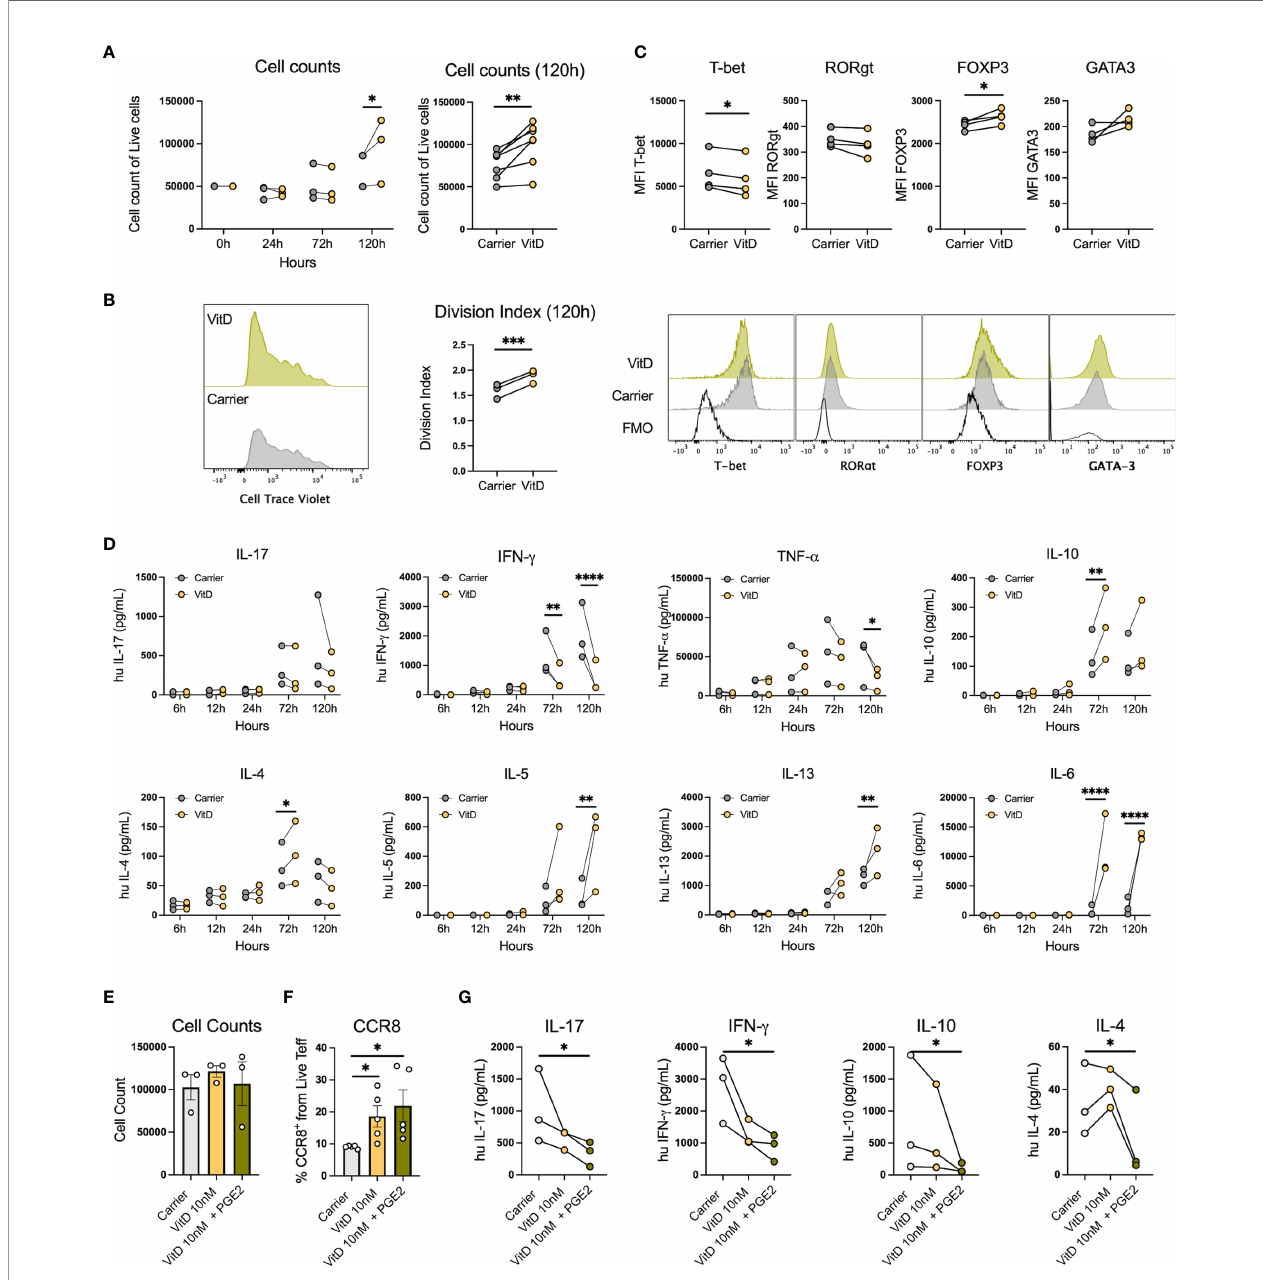
FIGURE 7 | PGE2 with VitD induce CCR8 expression and inhibit cytokine production in Th cells. (A) Representative histograms and cumulative data of cell counts and (B) division index of sorted memory Teffs (2×10 5 ) activated with anti-CD3/CD28 beads (1:5) in the presence or absence of 1,25(OH)VitD3 (10nM in ethanol) or Carrier (ethanol) at 24h, 72h and 120h post activation. Data are presented as individual symbols with paired lines (Two-way Repeated Measure ANOVA and Paired t test). (C) Representative histograms and cumulative data of transcription factor expression of sorted memory Teffs (2×10 5 ) activated with anti-CD3/CD28 beads (1:5) in the presence or absence of VitD (10nM in ethanol) or Carrier (ethanol) at 120h post activation. Data are presented as individual symbols with paired lines (Paired t test). (D) Cytokines were measured in supernatants obtained from sorted memory Teffs (2×10 5 ) activated with anti-CD3/CD28 beads (1:5) in the presence or absence of 1,25(OH)VitD3 (10nM in ethanol) or Carrier (ethanol) at 6h, 12h, 24h, 72h and 120h post activation. Data are presented as individual symbols with paired lines (Two-way Repeated Measure ANOVA). (E) Cell counts, (F) CCR8 expression and (G) cytokine production were measured in anti-CD3/CD28 pre-activated Teff cells (1x10 5 ) cocultured with carrier (ethanol), 1,25(OH)VitD3 (10nM in ethanol) or 1,25(OH)VitD3 (10nM in ethanol) in combination with PGE2 (5uM) for 72h with fl ow cytometry. Data is presented as mean ± SEM using column bars plots with bars with scatter dot plots for phenotype and individual symbols with paired lines values for cytokine production (Paired t test). For all statistical tests, ∗∗∗∗ p < 0.0001, ∗∗∗ p < 0.001, ∗∗ p < 0.01 and ∗ p < 0.05 were considered signi fi